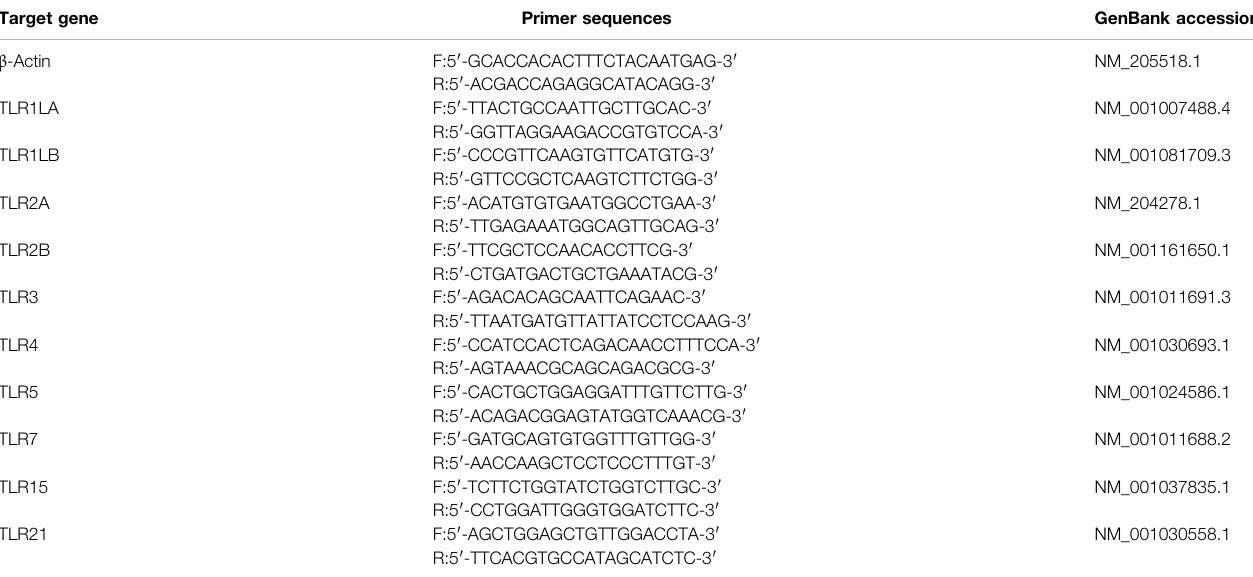
TABLE 4 | Primers of genes related to Toll-like receptors used for mRNA